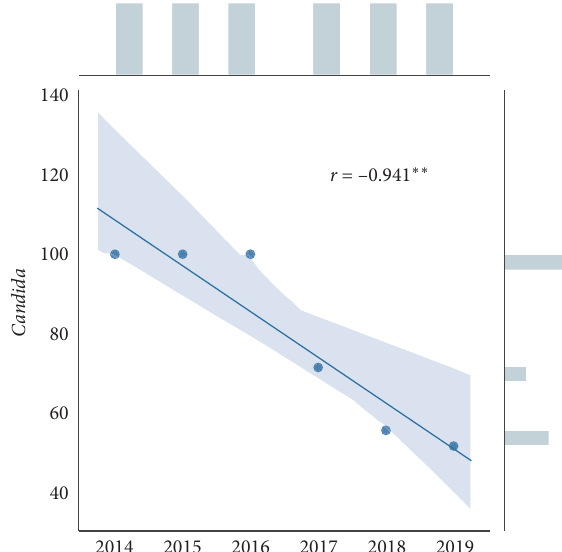
Figure 4: Spearman’s correlation coefficients— Candida .